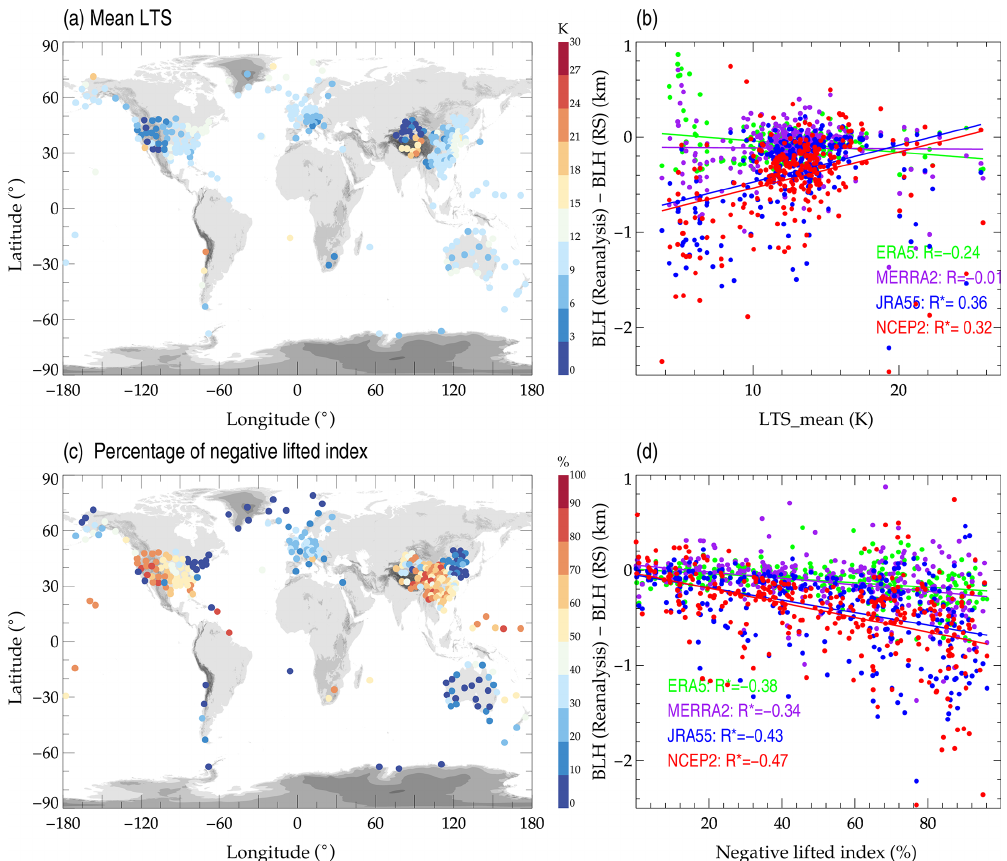
Figure 12. Spatial distribution of the ensemble means of lower tropospheric stability in the daytime (a) . The scatter plots showing the difference of model-derived minus sounding-derived BLHs from four reanalysis datasets versus the anomalies of LTS as derived from four reanalysis relative to those from soundings (b) . The variations in the percentage of the negative lifted index (c) , and the anomalies of BLH as a function of the negative lifted index (d)